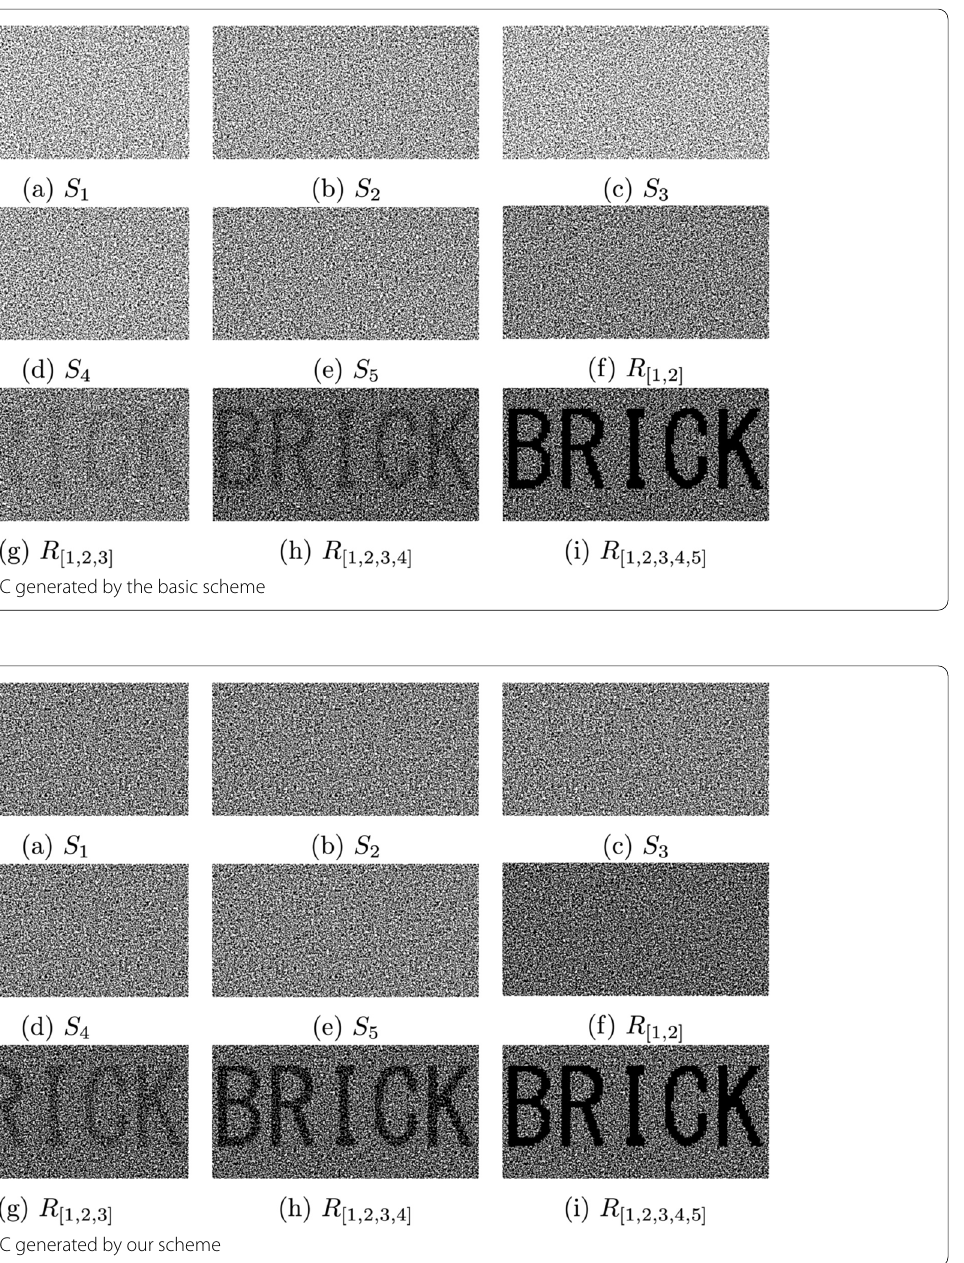
Fig. 3 Example of the (3,5)-PVC generated by our